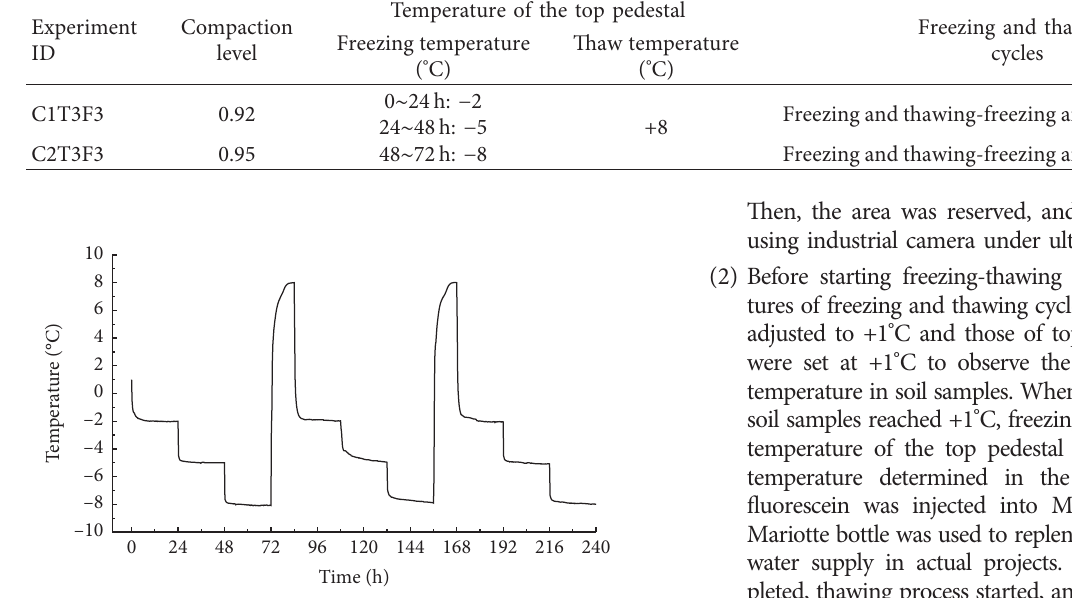
Figure 4: The temperature variation of the top cooling